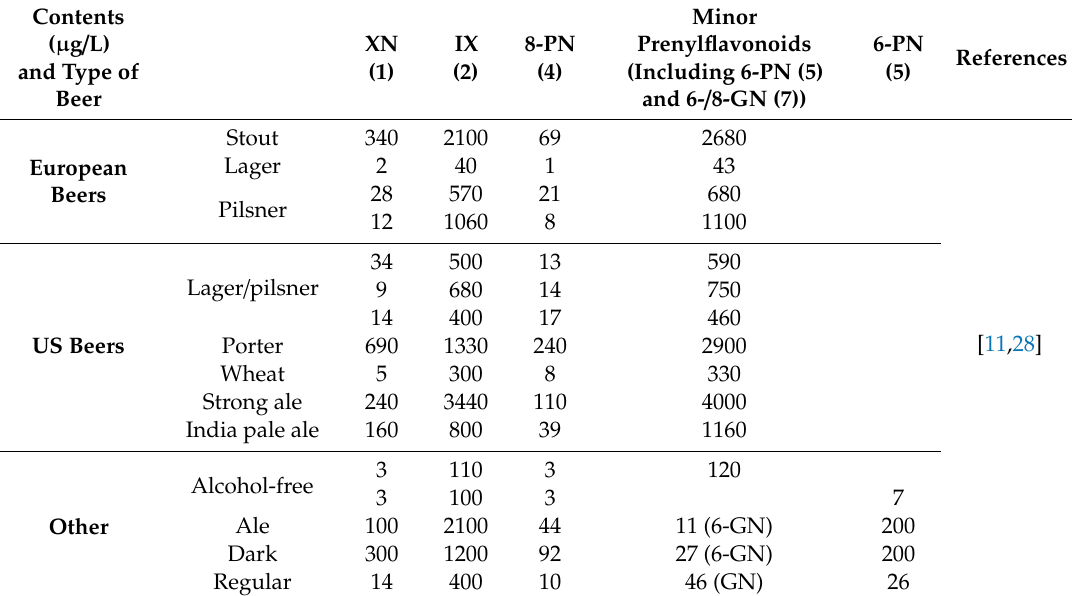
Table 1. Prenylflavonoids contents in di ff erent type of